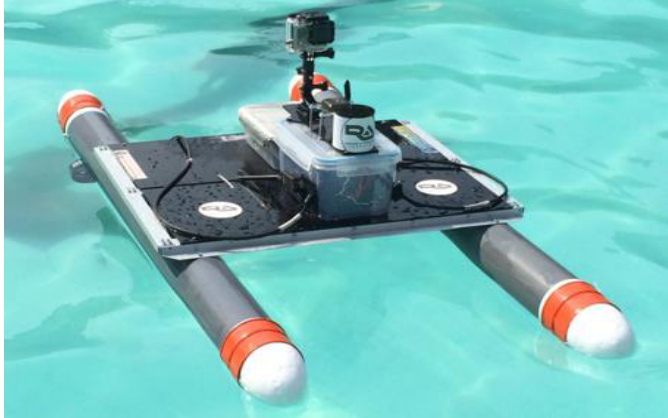
Figure 6. The result prototype of USV.